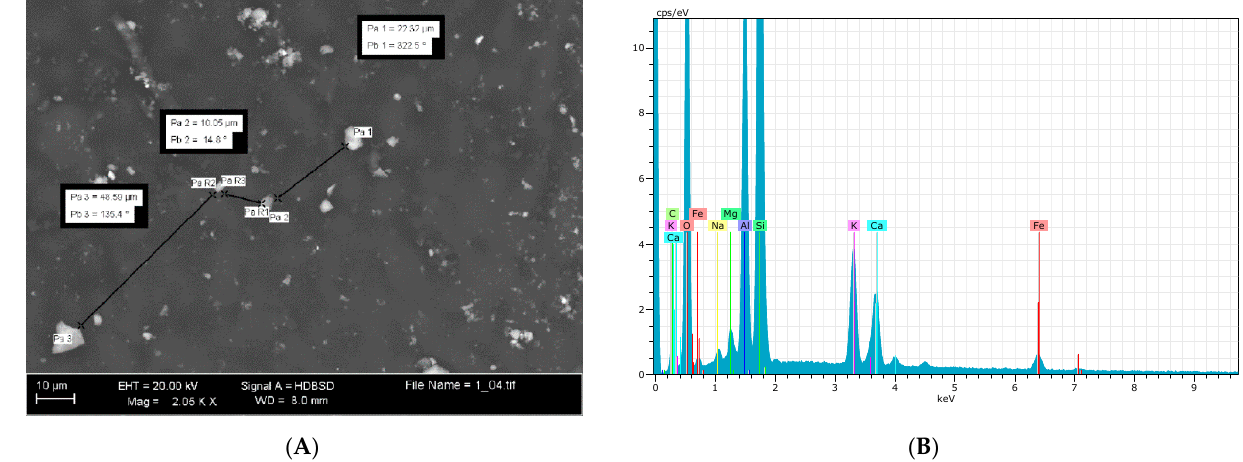
Figure 1. ESEM observations of CHA-zeolitite leaf coating to check the distribution protocol. ( A ) Measurements of the distance between CHA-zeolitite particles; ( B ) CHA-zeolitite particles’ composition by